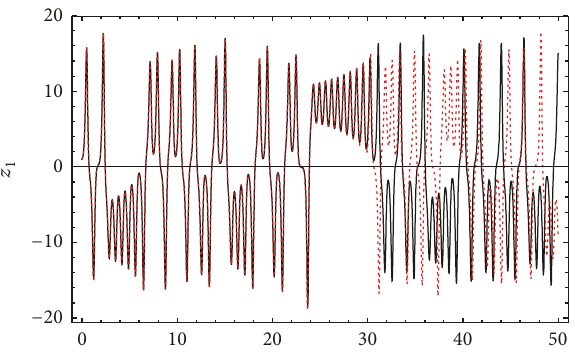
= 1000 , 𝑧 = 1 = 𝑧 = 1 , 𝑧 = 20 , 𝜎 = 10 , 𝑑 1 2 3